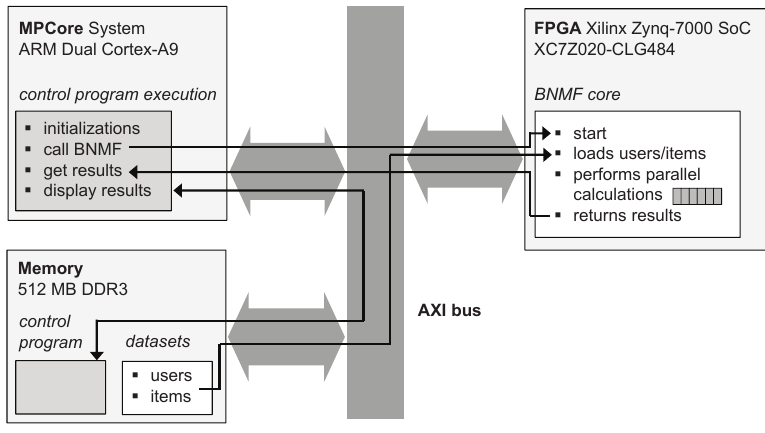
Figure 3. Basic architecture for BNMF on the Zynq Zedboard